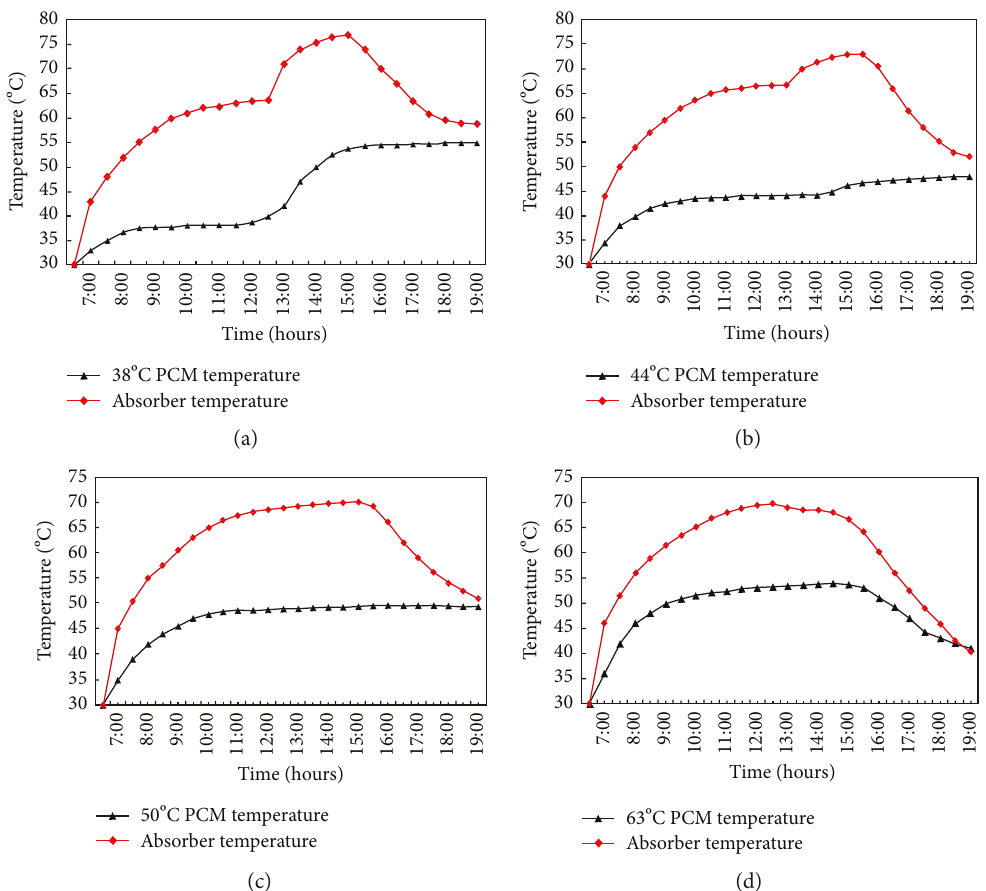
Figure 4: Absorber temperature and PCM temperature for four di ff erent PCMs when storing heat during the day.